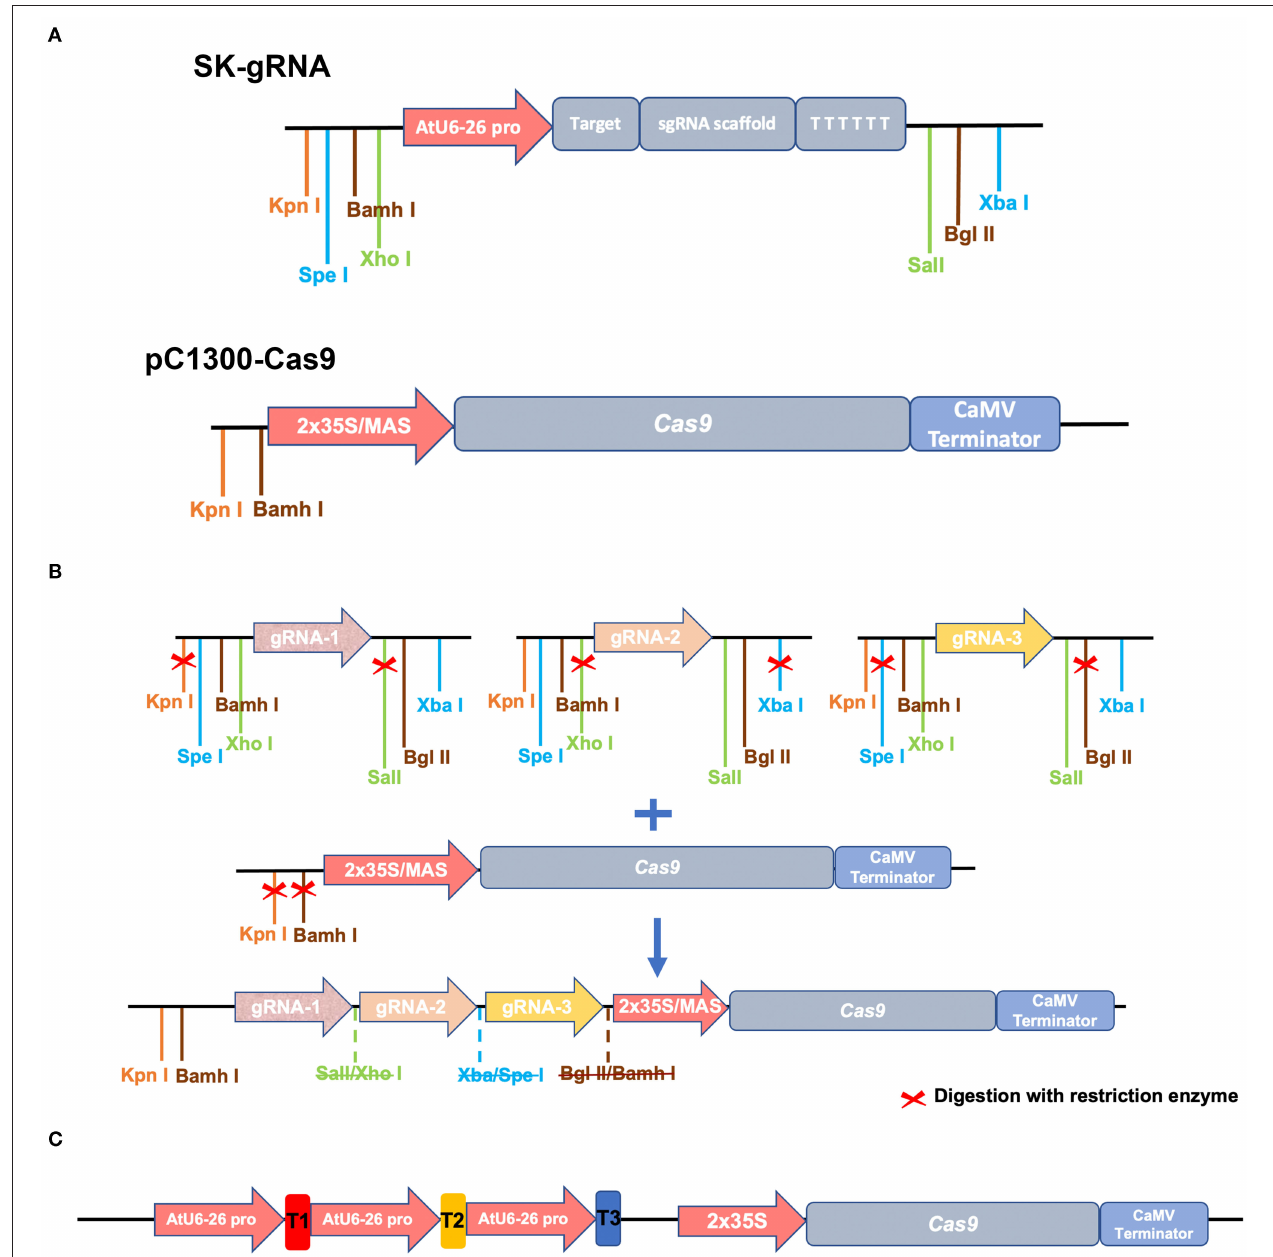
FIGURE 2 | Schematic diagram illustrating the structure of vectors and construction strategy. (A) The intermediate vector SK-gRNA contains the U6 promotor, an sgRNA scaffold, and the terminator. The restriction sites used for cloning are indicated. Binary vector pC1300-Cas9 contains the 2 × 35S or MAS promotor, a codon-optimized Cas9 coding sequence, and the CaMV terminator. (B) Vector construction strategy. Kpn I and BamH I sites are indicated in front of the 2 × 35S or MAS promotor. Three gRNA scaffolds with PagPDS targets are, respectively, digested (contains Kpn I, BamH I, Xho I, Sal I, Xba I, and Spel I) and cloned into pC1300-Cas9 between the Kpn I and BamH I sites in a one-step ligation. (C) Structure of destination vectors used in the CRISPR/Cas9 system.